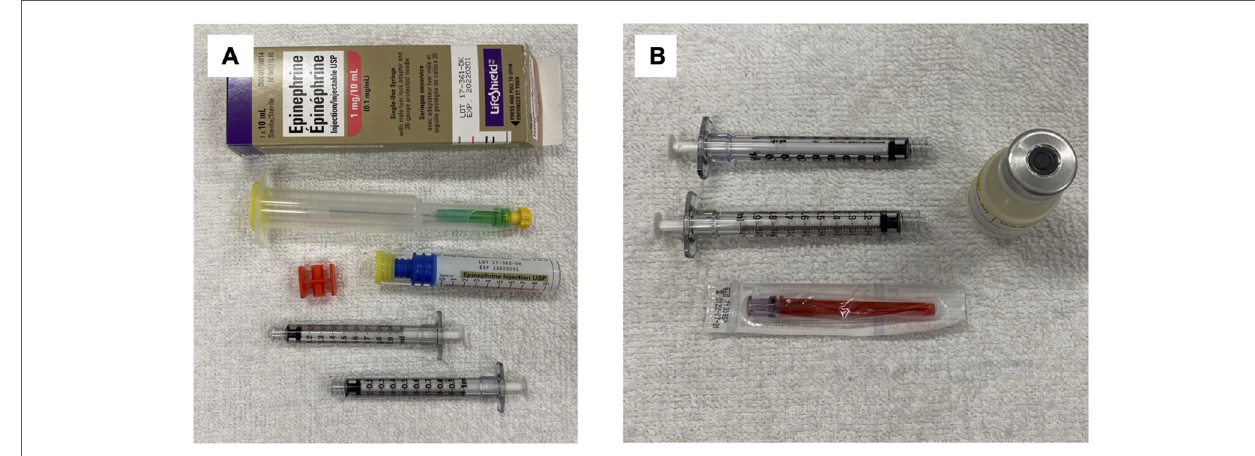
FIGURE 1 Epinephrine adult pre fi lled syringe for neonatal doses ( A ) vs. Simulated Multi-access Vial ( B